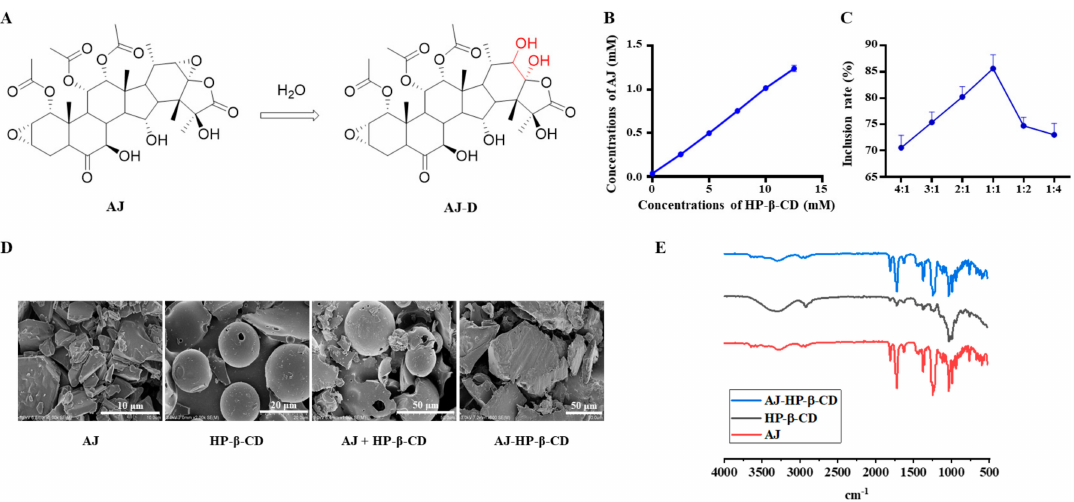
Figure 1. Preparation and characterization of taccalonolide AJ-hydroxypropyl- β -cyclodextrin (AJ-HP- β -CD). ( A ): The major hydrolysis compound of AJ. ( B ): The phase solubility diagram of AJ at 27 ◦ C; ( C ): Molar ratio of AJ:HP- β -CD, Data are expressed as the mean ± standard deviation (SD). Statistical analysis was calculated using Student’s t -test ( n = 3). ( D ): SEM images of AJ, HP- β -CD, physical mixture, and AJ-HP- β -CD. ( E ): FT-IR diagram of AJ (red), HP- β -CD (black), and AJ-HP- β -CD